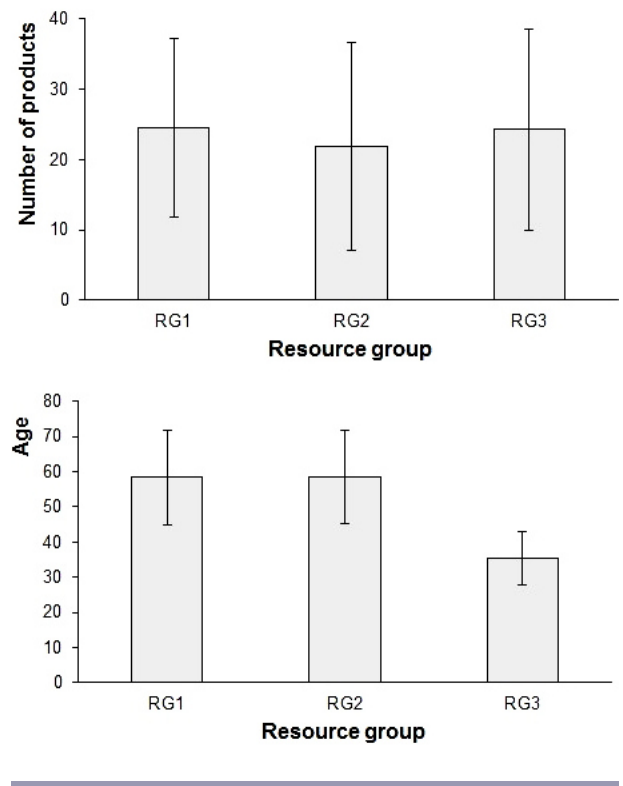
Fig. 5 . Number of edible nontimber forest products species mentioned per household per resource group (RG), and average age of the respondents. Bars show the standard error of